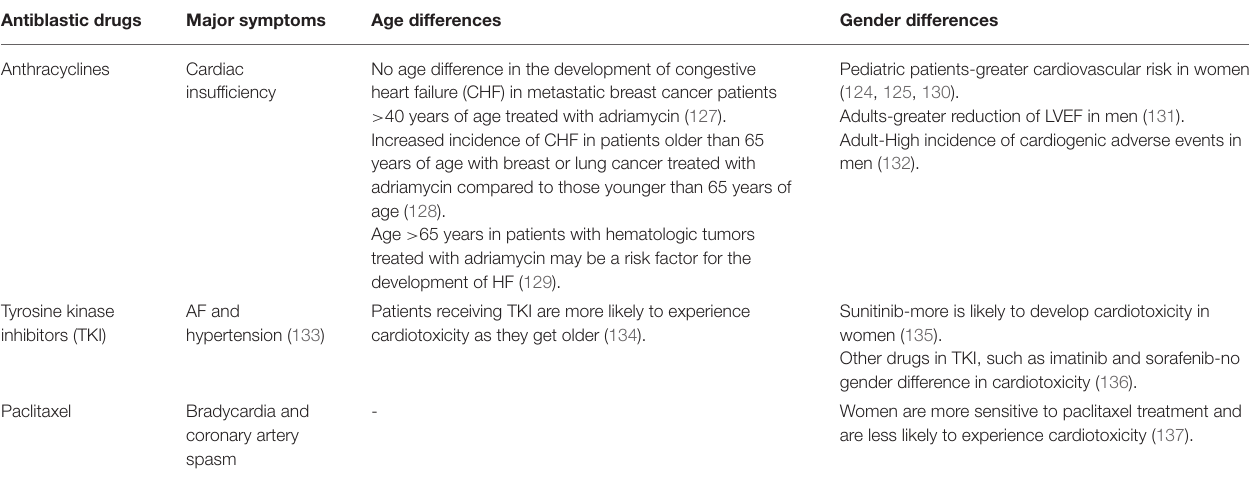
TABLE 2 | Differences in cardiotoxicity due to antineoplastic drugs. Antiblastic